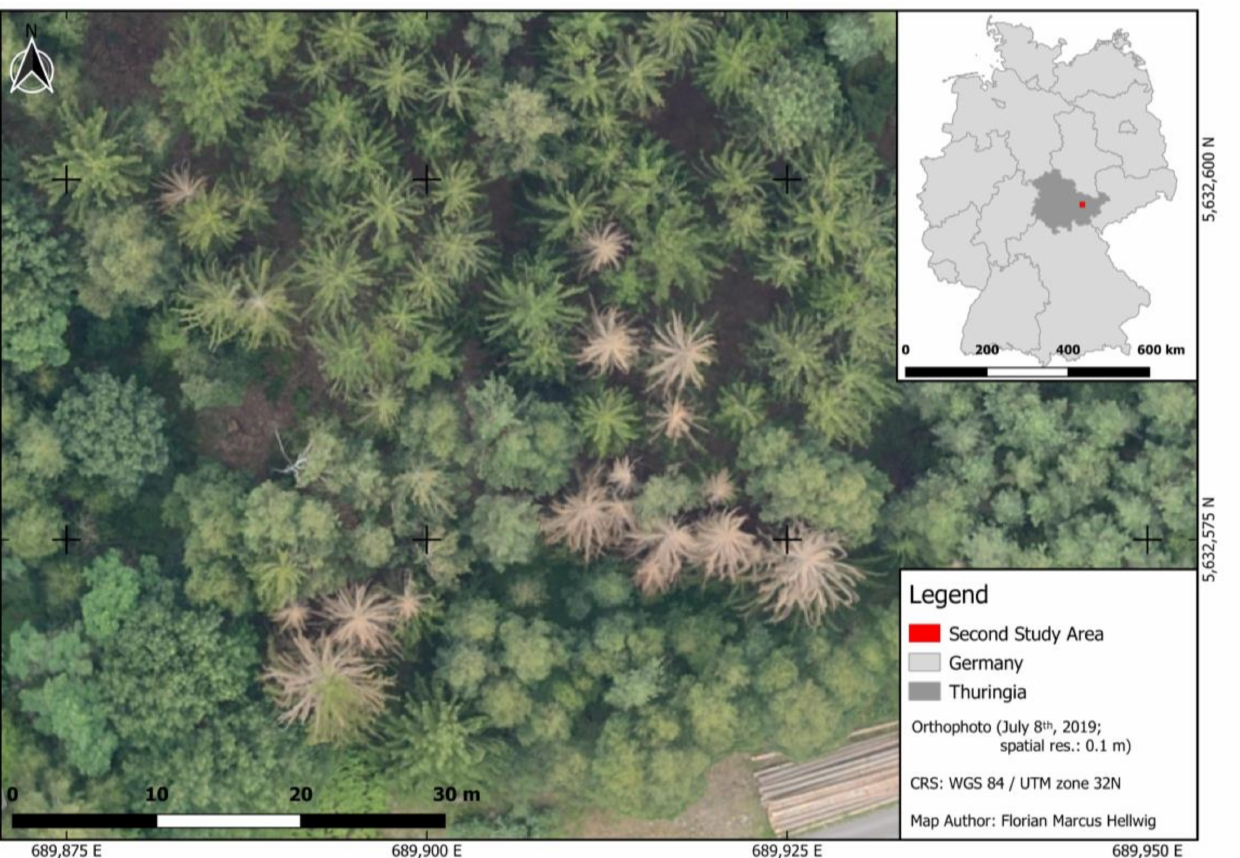
Figure 2. Second study area within a mixed deciduous and spruce forest (8 July 2019). Infested spruces (“brown crown”), visible from the brown discoloration of the tree crown, stand next to healthy spruces. Infestation stages of the spruces are shown in Table